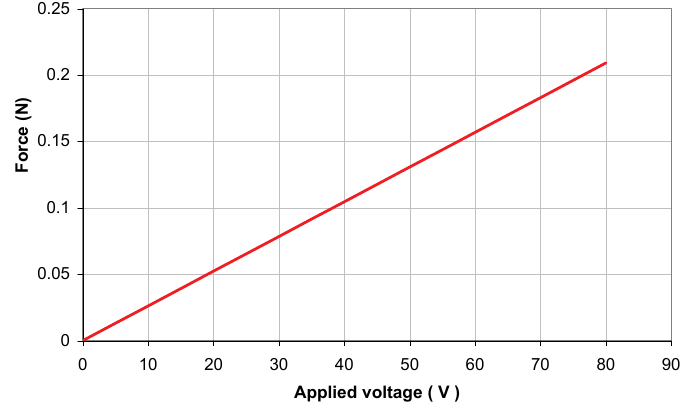
Figure 12. Blocking force at the tip of piezoelectric bimorph versus applied voltage.